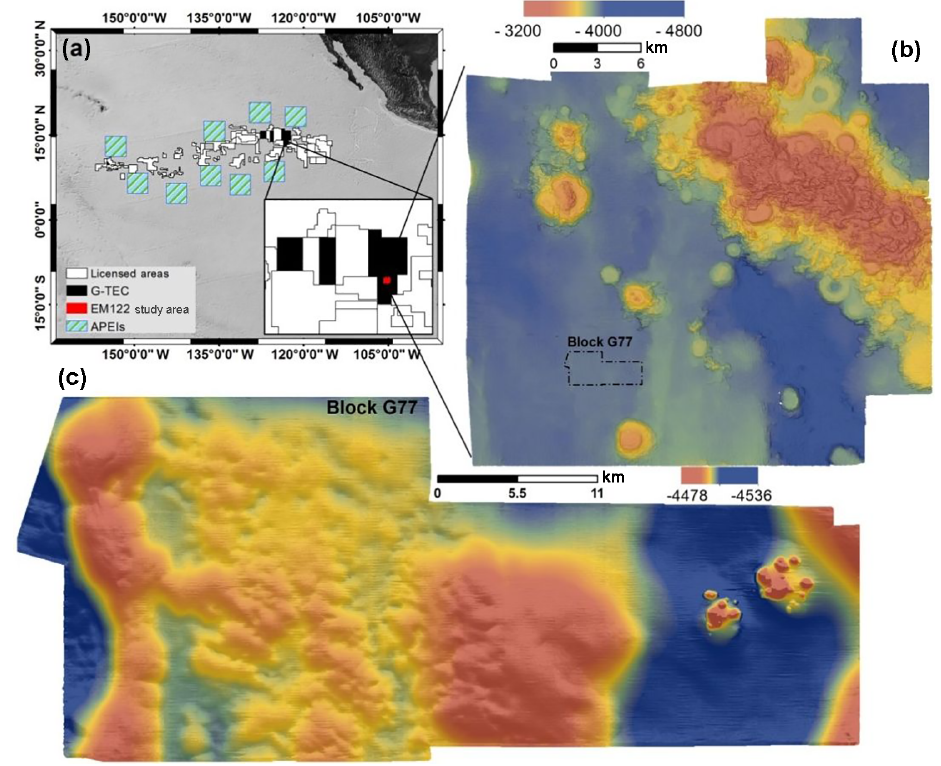
Figure 2. (a) Areas of Particular Environmental Interest (APEIs), licensed areas (white), and the Belgium/GSR licenses area (black) within the CCZ. (b) Regional bathymetric map of the study area, created by the EM 122 MBES on R/V Sonne (cruise SO239). (c) Block G77, mapped by AUV Abyss with a Teledyne Reson Seabat 7125